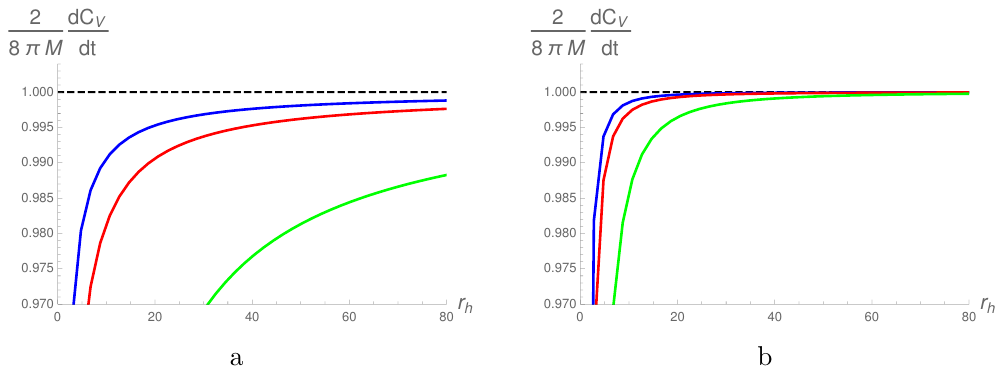
Figure 10 . Panel (a) shows the variation of dC V vs r h for d = 3 for n = 1 in the late time limit dt and (b) shows the same variation for d = 3 and n = 2. In both cases, the dotted line represents dC V the ratio 2 . The blue curves indicate a = 0 : 05, the red curves a = 0 : 1 and the green curves 8 (cid:25)M dt a = 0 :